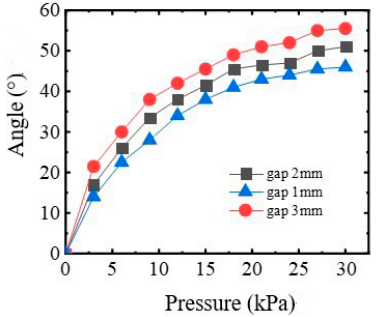
Figure 8. The effect of gap on the performance of rotating actuator for four fingers.